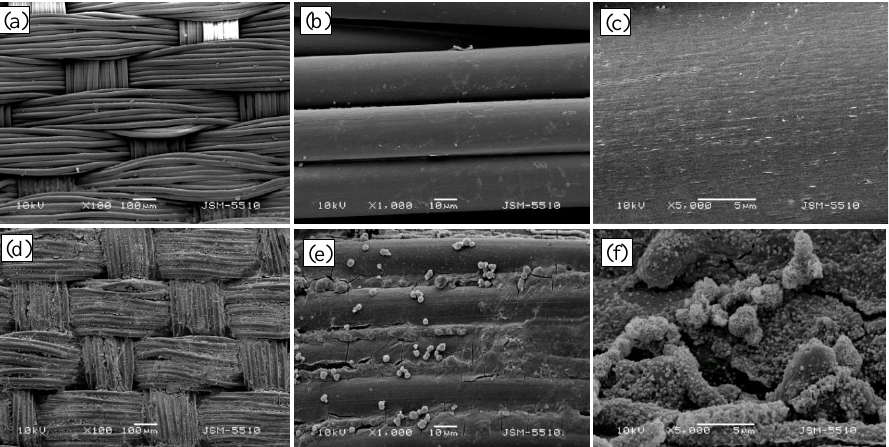
Figure 2. SEM images of the pristine polyamide fabric at different magnification: ( a ) ×100; ( b ) ×1000; ( c ) ×5000 and of composite material PA30: ( d ) ×100; ( e ) ×1000; ( f ) ×5000.